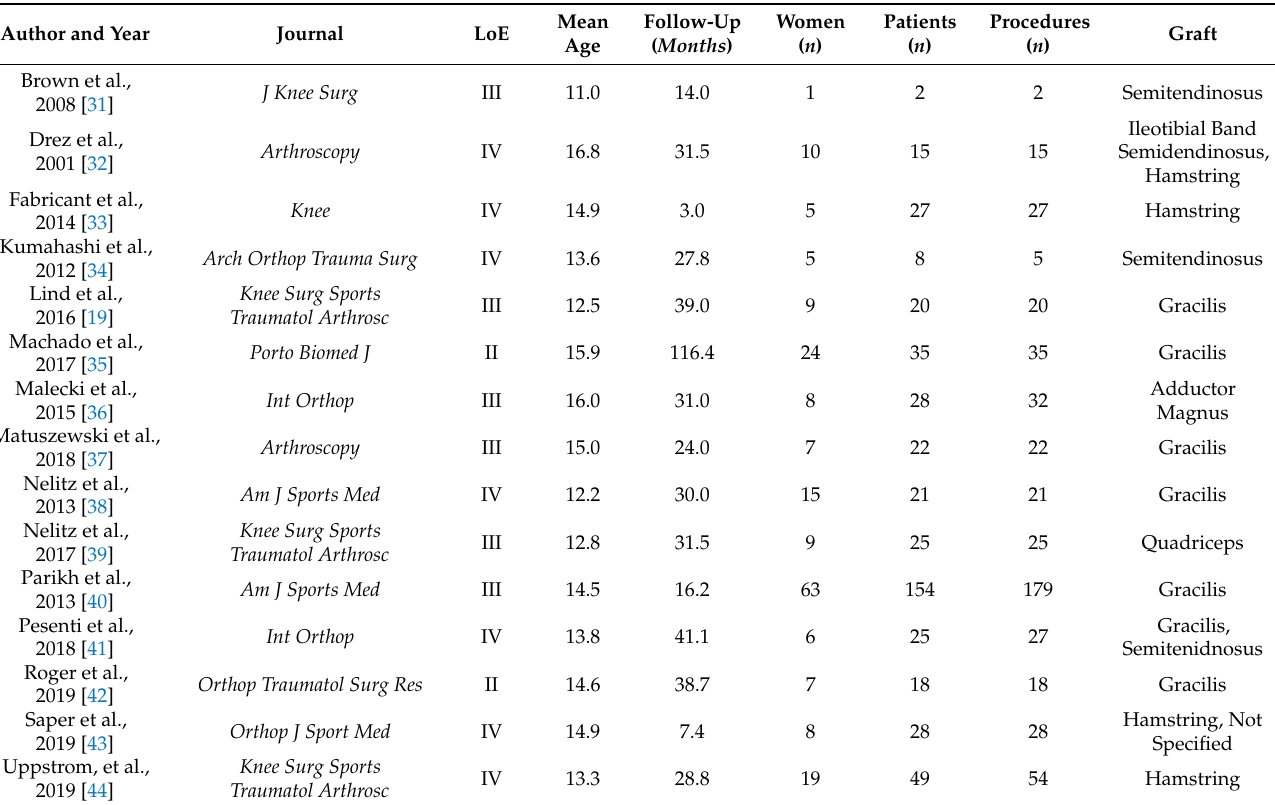
Table 1. Baseline patient demographics (LoE: level of evidence).